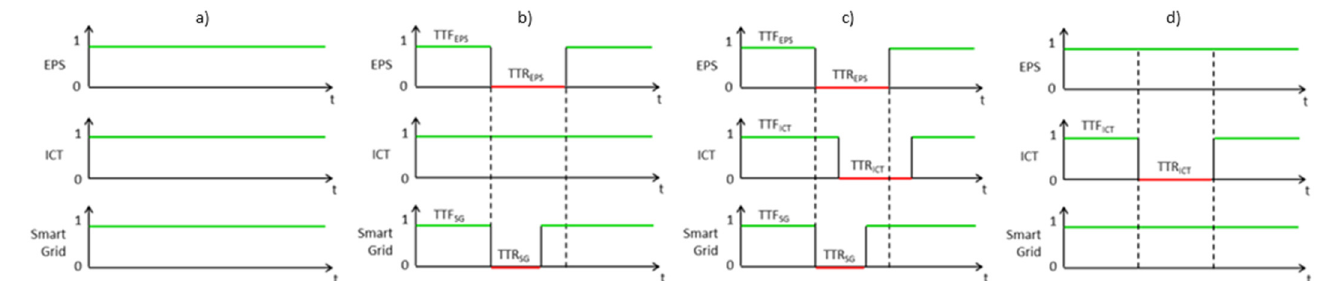
Figure 5. Methodology of smart grid co-simulation: a) EPS, ICT and Smart Grid in operation, b) outage in EPS, ICT in operation, shortening the failure in Smart Grid, c) failure in EPS, failure in ICT, shortening the failure in Smart Grid, d) EPS in operation, failure in ICT, Smart Grid in operation [80,81].